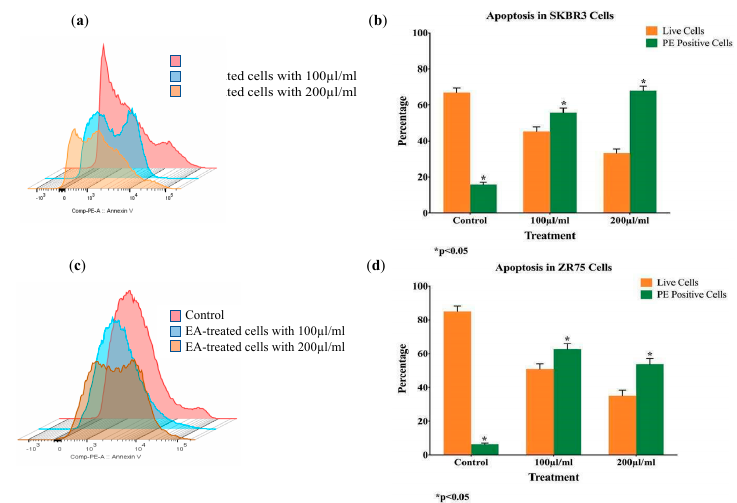
Figure 3. ( a , b ) Induction of apoptosis by EA extract in SKBR3 ( a , b ) and ZR75 ( c , d ) cells, as determined by Annexin V-FITC and 7-AAD apoptosis assay. Next, we examined the cell morphology of SKBR3 and ZR75-1 in addition to HNME-E6/E7 cell lines, using phase-contrast microscopy, under the effect of 100 and 200 µL/mL of EA extract. In the absence of treatment, SKBR3 and ZR75-1 cells displayed a round morphology and disorganized multilayered cells. In contrast, and as indicated in Figure 4a, treatment for 48 h with 100 and 200 µL/mL of EA plant extract led to a phenotypic conversion from round cells to epithelial-like phenotype. Clearly, cells became more flattened in appearance and showed an increase in cell-cell adhesion, in comparison with untreated cells (Figure 4a). However, at three days of treatment with 200 µL/mL of EA plant extract, cells started detaching from the surface of the tissue culture dish, indicating cell death in SKBR3 and ZR75-1 cells; however, this was not observed in the human normal immortalized mammary epithelial cell line (HNME-E6/E7), as shown in Figure 4b. Nevertheless, it is evident that EA extract inhibits cell proliferation HNME-E6/E7 cells, with a slight effect on their epithelial morphology (Figure 4b).